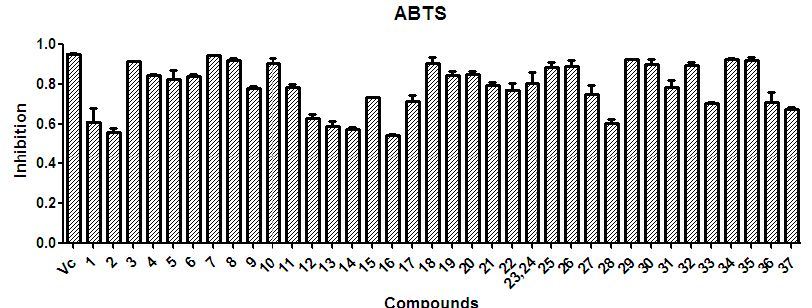
Figure 6. The radical-scavenging activity of the polyphenols ( 1 – 37 ) isolated from X. sorbifolia husks. ABTS was prepared daily and diluted to an absorbance of 0.70 ± 0.02 at 734 nm. After the crude samples (50 µg/mL) reacted with the ABTS radical solution for 10 min, the absorbance values ( Ai ) at 734 nm were measured, and the percentage inhibitions were calculated. Vc, ascorbic acid.